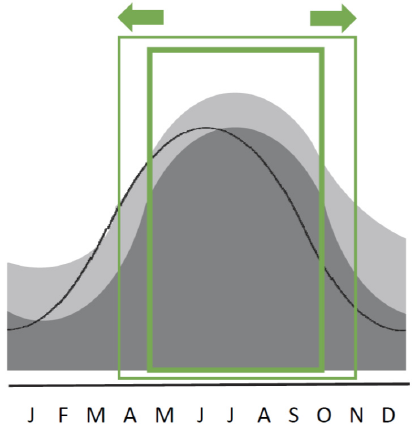
Figure 1. The thermal growing season and annual variation in photoperiod and temperature at a northern latitude. With higher temperatures in the future (light grey area), the thermal growing season will extend in both ends (outer green box) as compared to today (dark grey area and inner green box). The annual changes in temperature (grey area) lags behind the annual changes in photoperiod (black line). With higher temperatures in the future, but the same photoperiod variation as today, we will have new combinations of temperature and photoperiod.